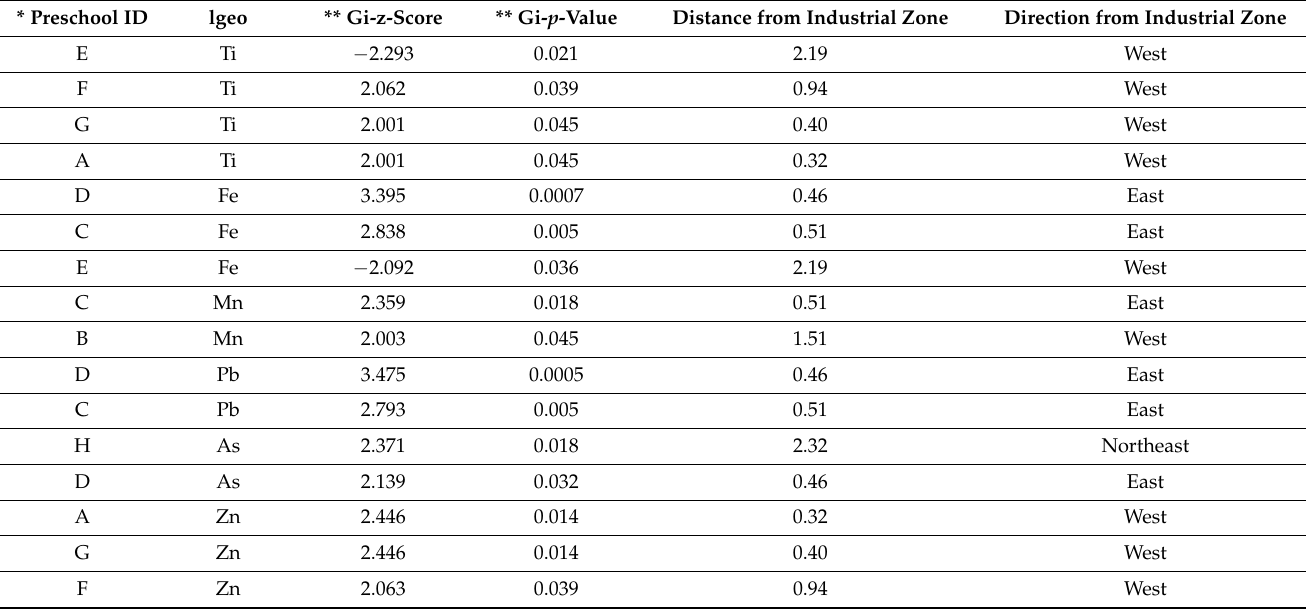
Table 3. Z-score values for heavy metals at preschools in relation to the industrial zone.